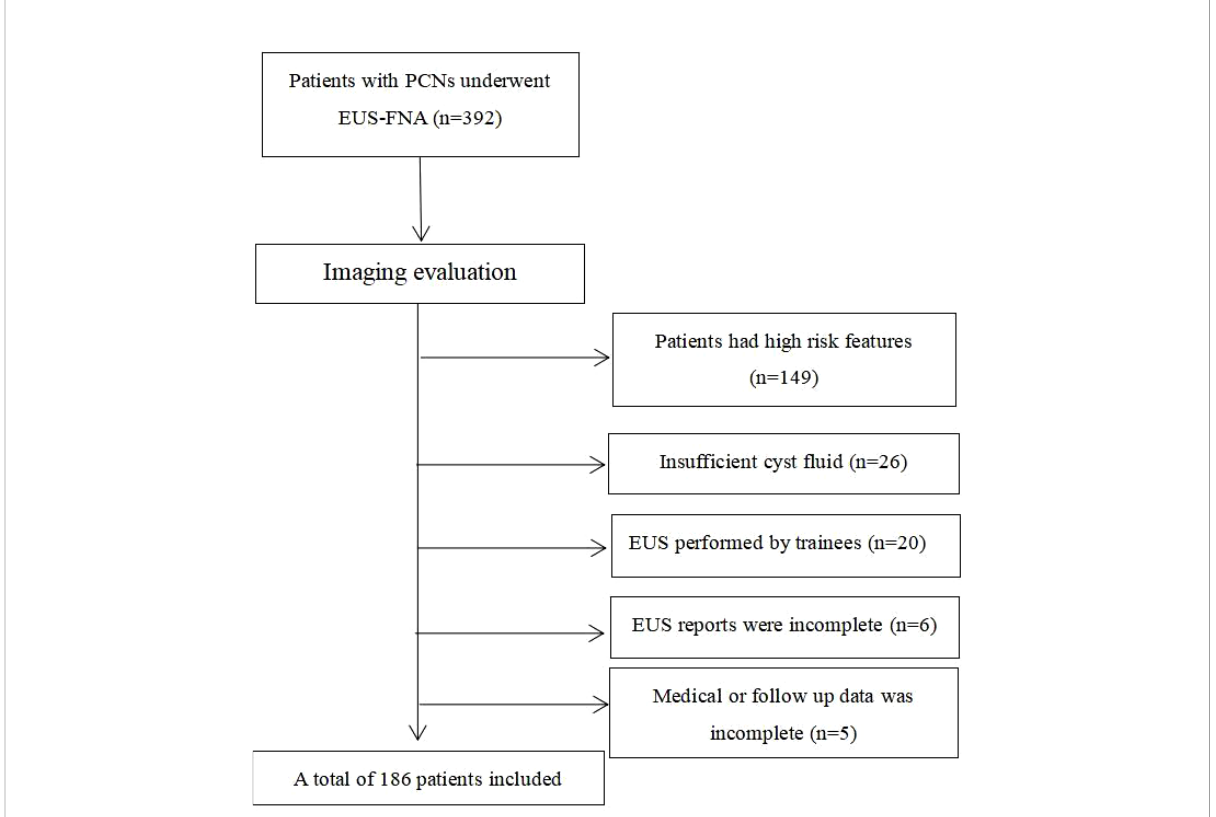
FIGURE 1 Patient selection fl owchart (PCN, pancreatic cystic neoplasm; EUS-FNA, Endoscopic ultrasound guided fi ne needle